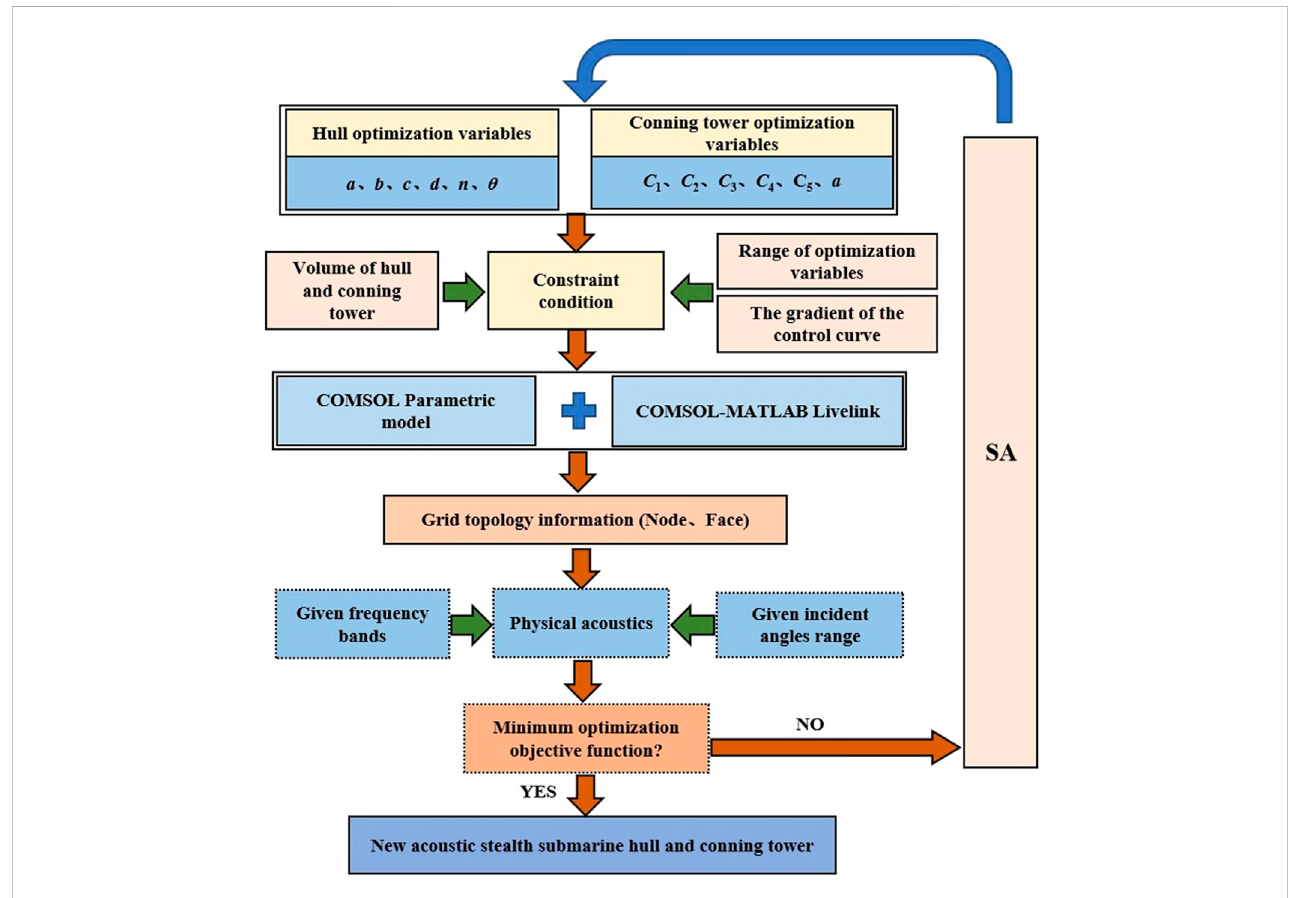
FIGURE 2 Schematic diagram of hull and conning tower optimization method.